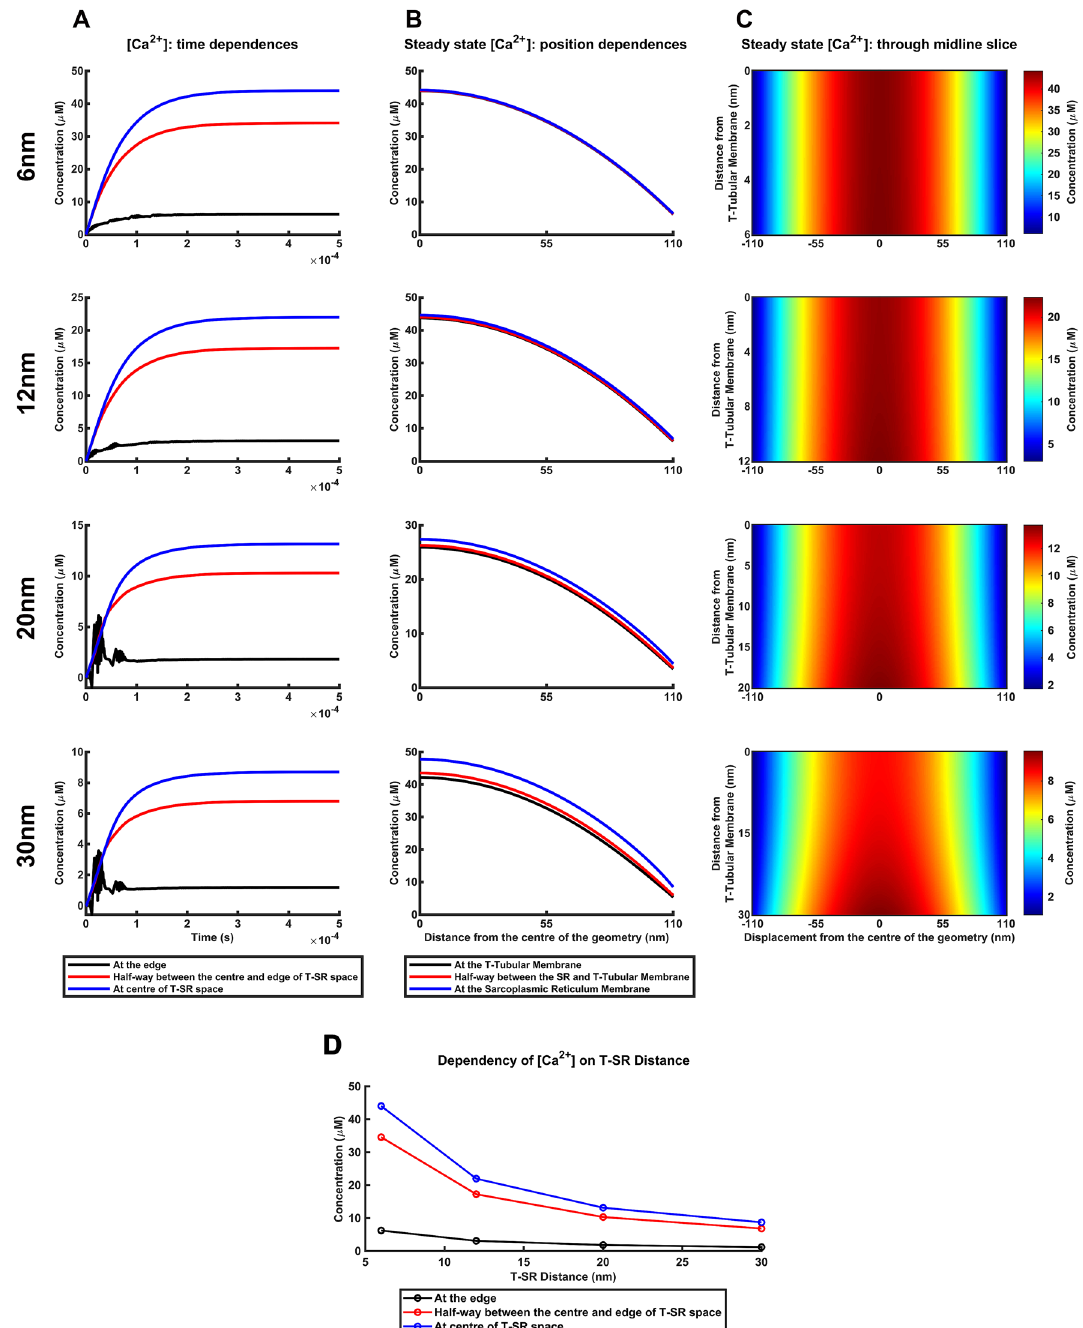
Figure 5. Altered Ca 2+ microdomain characteristics with increased T-SR distances.. ( A - C ) The effect of variations in reported experimental values of T-SR distance, w , ranging from lowest reported values in hypertonic extracellular conditions to the greatest values associated with fatiguing exercise at constant imposed Ca 2+ influx density, J influx diffusion coefficient, D , and TSR diameter, d . ( A ) Variations in [Ca 2+ ] with time following onset of imposed J influx . ( B ) Resulting variations in steady state [Ca 2+ ] with radial distance from the centre of the T-SR junction; note significant differences in the [Ca 2+ ] magnitudes close to the T-tubular, the sarcoplasmic reticular (SR) membranes, and the intervening T-SR region. ( C ) Mapping of [Ca 2+ ] across a midline axial slice; values of [Ca 2+ ] are scaled linearly with maximum concentration at centre of T-SR junction [Ca 2+ ] to illustrate features of microdomain characteristics and the radial concentration gradients. Note marked pluming of the Ca 2+ microdomain with increasing T-SR distance. ( D ) Dependence of T-SR junctional [Ca 2+ ] at the centre, the edge, and halfway between these upon T-SR distance, w . Relationships emerging from plots of [Ca 2+ ] TSR centre , [Ca 2+ ] TSR 50% and [Ca 2+ ] TSR edge , against T-SR distance, w , at constant diffusion coefficient, D , influx density, J influx and T-SR diameter, d